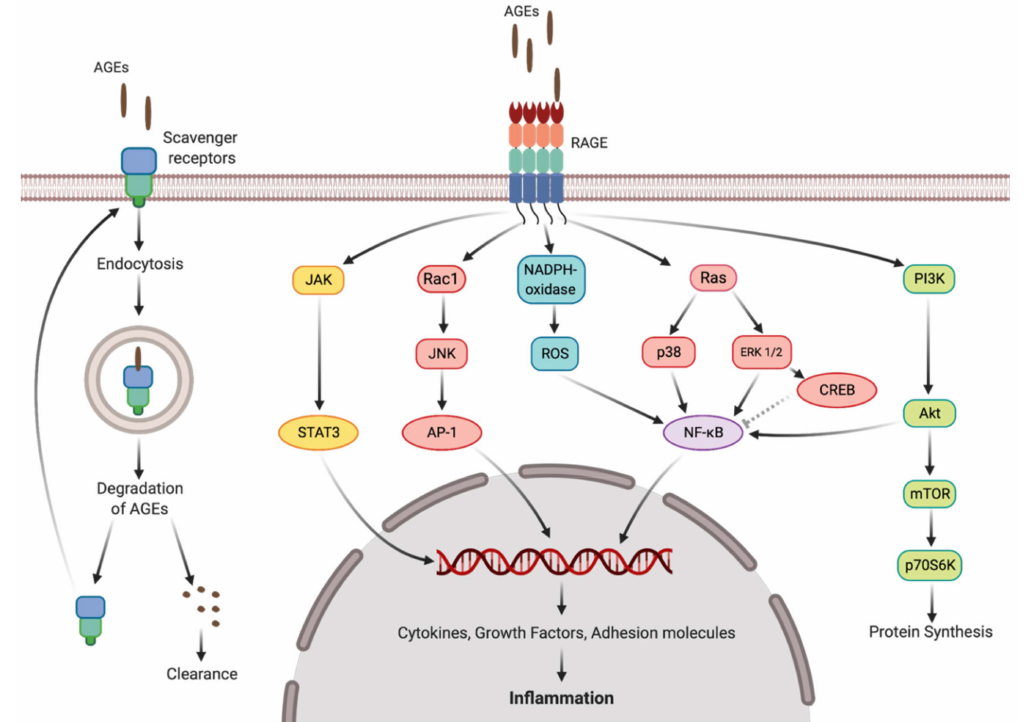
Figure 10. Advanced glycation end product (AGE)-mediated signaling events triggered by AGE-RAGE interaction and degradation of AGEs via lysosomal system. AGEs, advanced glycation end products; Akt, RAC-alpha serine / threonine-protein kinase; AP-1, activator protein 1; CREB, cAMP response element-binding protein; ERK 1 / 2, extracellular signal–regulated kinases 1 / 2; JAK, Janus kinase; JNK, c-Jun N-terminal kinases; mTOR, mammalian target of rapamycin; NF-B, nuclear factor kappa-light-chain-enhancer of activated B cells; p38, p38 mitogen-activated protein kinases; p70S6K, ribosomal protein S6 kinase; PI3K, phosphoinositide 3-kinases; RAGE, receptor for advanced glycation end products; ROS, reactive oxygen species; STAT3, signal transducer and activator of transcription